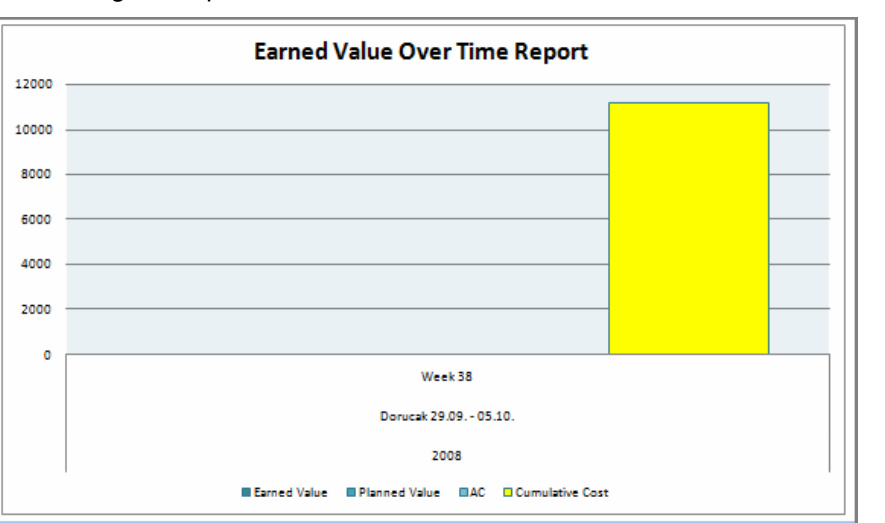
U tabeli vidimo ukupne troškove. Ako odaberemo list Chart 1 može- mo videti i grafi č ki